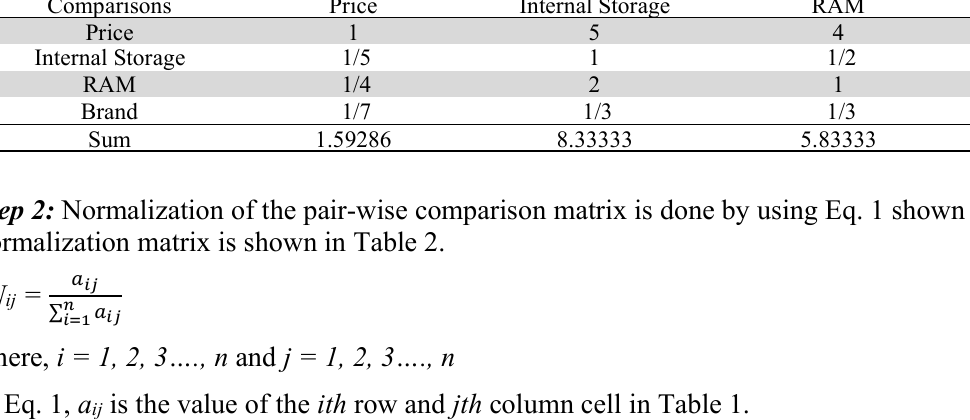
Normalization Matrix Comparison Price Internal Storage RAM Row Average Internal Storage